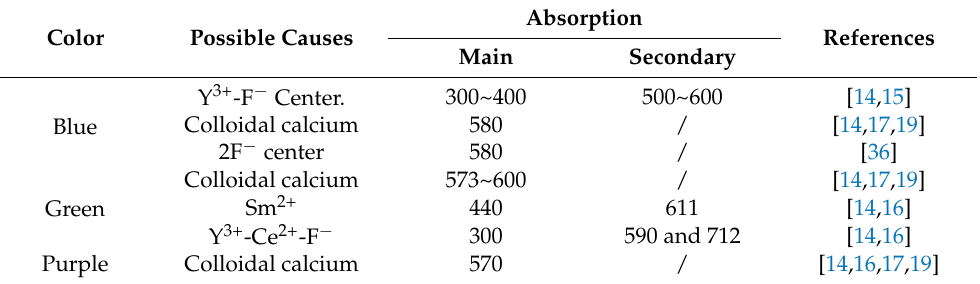
Table 3. Characteristic absorption peak and peak assignment of fluorite in UV-Vis spectrum (unit: